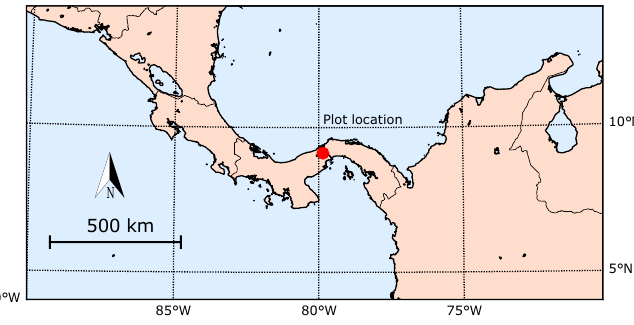
Figure 1. Map of the study site with the location of the removal and control plots marked with the red dot. The study site is located in Gigante Peninsula in Panama (9 ◦ 9 (cid:48) N, 79 ◦ 51 (cid:48) W) adjacent to Barro Colorado Island